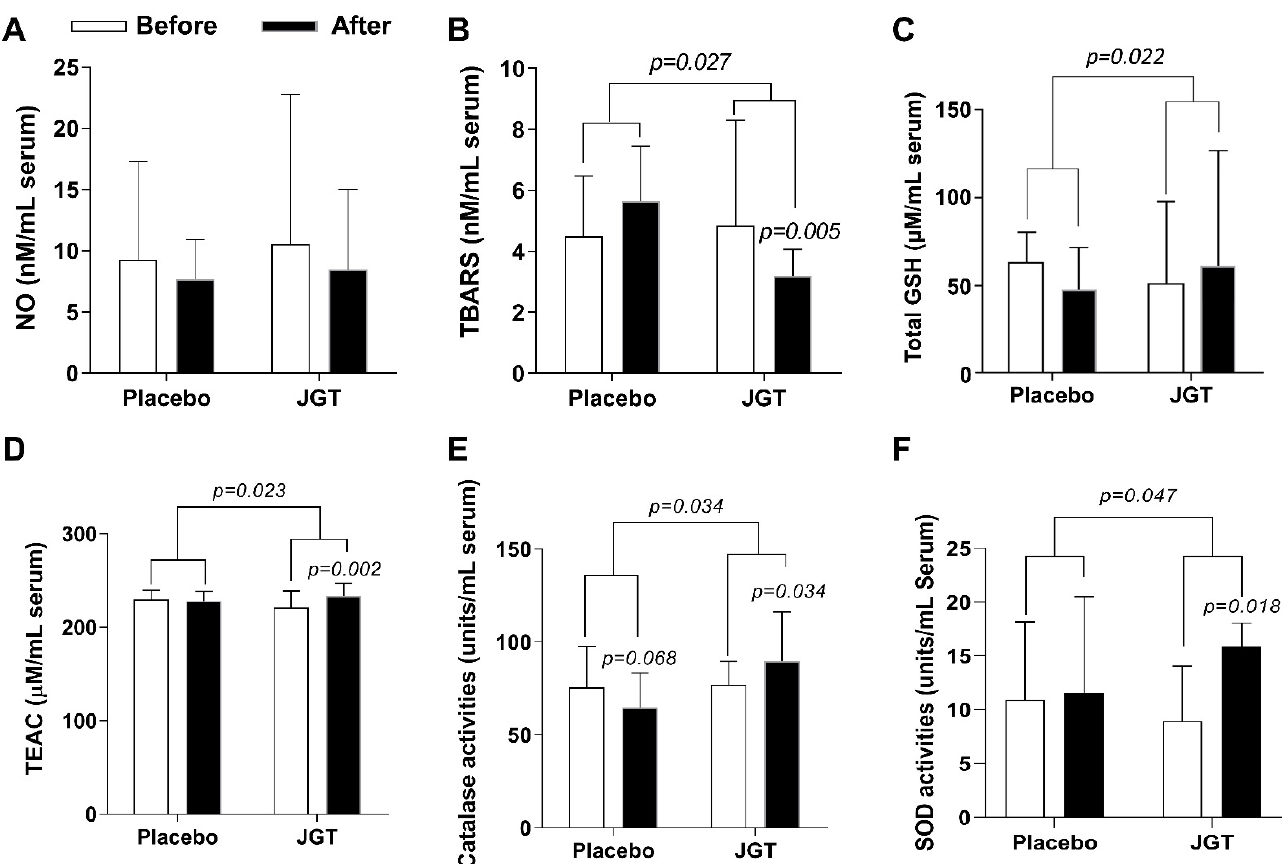
Figure 1. Effects of JGT on the oxidative stress and antioxidant components in the serum levels. Serum levels of ( A ) NO (nitric oxide), ( B ) MDA (malondialdehyde, measured by thiobarbituric acid reactive substances (TBARS) assay), ( C ) total GSH (glutathione), ( D ) TEAC (Trolox equivalent antioxidant capacity), ( E ) catalase activities, and ( F ) SOD (superoxide dismutase) activities were measured after the completion of trials. Data were expressed as mean ± SD. p -values were calculated by comparing before and after treatment changes within each group and between the two